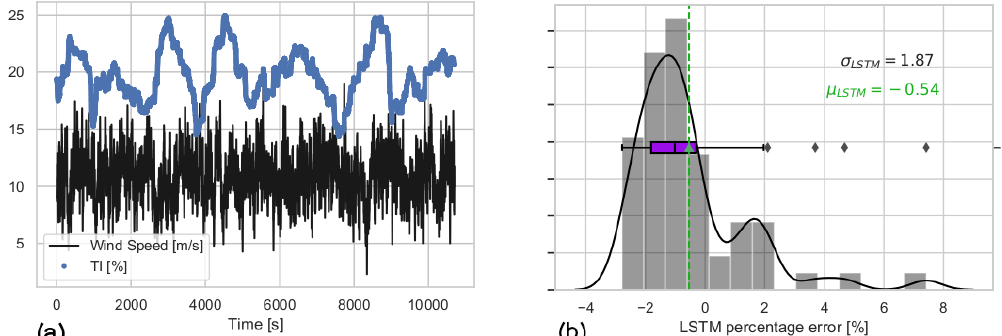
Figure 17. Input time series and 1min prediction error of the further transfer learning LSTM model, higher-turbulence-intensity flow case. Mean wind speed = 11ms − 1 and TI = 20% over the 60min test case. (a) Time series of the inflow dataset for the higher-TI test of the further transfer learning LSTM model, originally trained for mean wind speed = 11ms − 1 and TI = 10%. (b) The 1min average percentage error of the further transfer learning LSTM model under higher